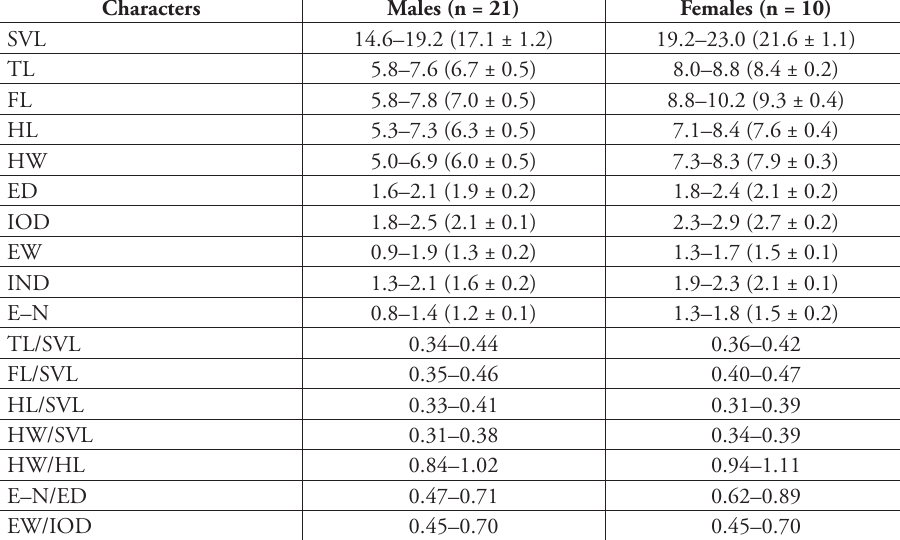
Table 4. Measurements (in mm) and proportions of adult male and adult female type specimens of Pristimantis attenboroughi sp. n.; ranges followed by means and one standard deviation in parentheses. For abbreviations see